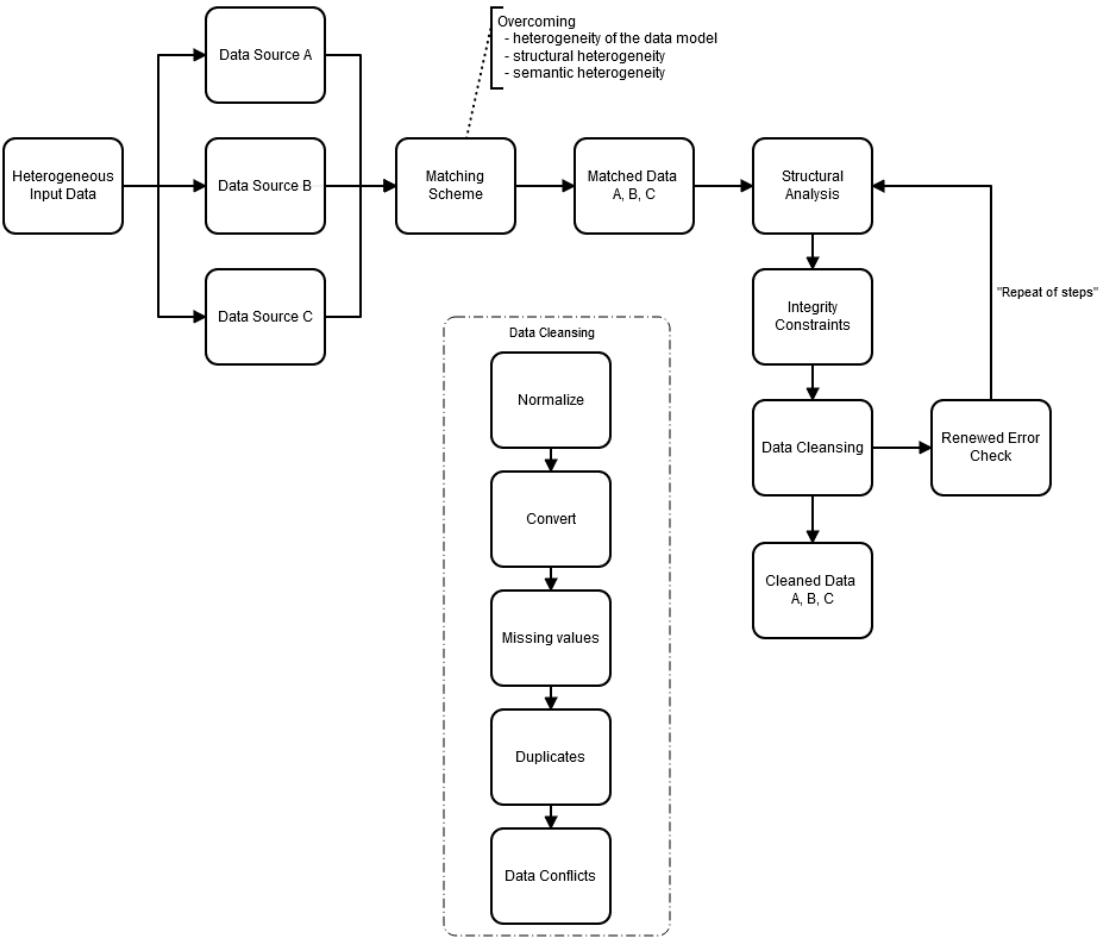
Figure 2. Framework for the elimination of bad research data.